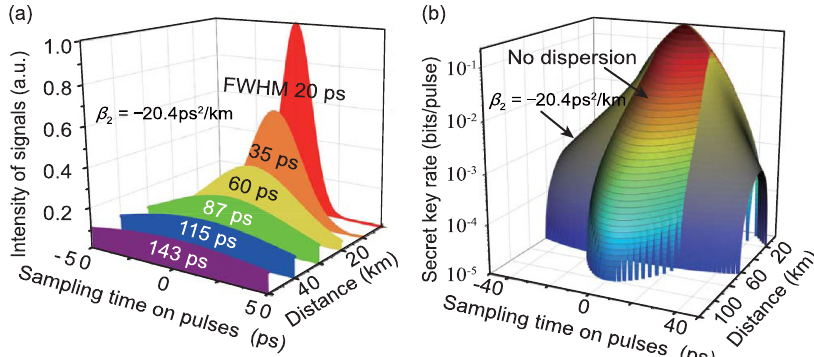
Fig. 3 Simulation results of the channel dispersion effect. a Evolution of the envelope of a Gaussian pulse with a full width at half-maximum (FWHM) of 20 ps in optical fi bers, ignoring the fi ber loss, where β 2 = − 20.4 ps 2 /km is considered, which is a typical value of standard G.652 telecom fi ber at 1550 nm. b Secret key rates for narrow-pulse (Gaussian pulse) propagation considering fi ber-dispersion-induced TM mismatch, where β 2 = 0 ps 2 /km and β 2 = − 20.4 ps 2 /km are considered, which are typical values of no dispersion channel and the standard G.652 telecom fi ber at 1550 nm. In the simulation, we use the single-sampling-point scheme, and the sampling time accuracy is considered. The sampling time t = 0 ps is assumed as the peak of Gaussian pulse. It is shown that the increasing mode mismatch reduces the secret key rate while also relaxing the accuracy requirement of the sampling time.